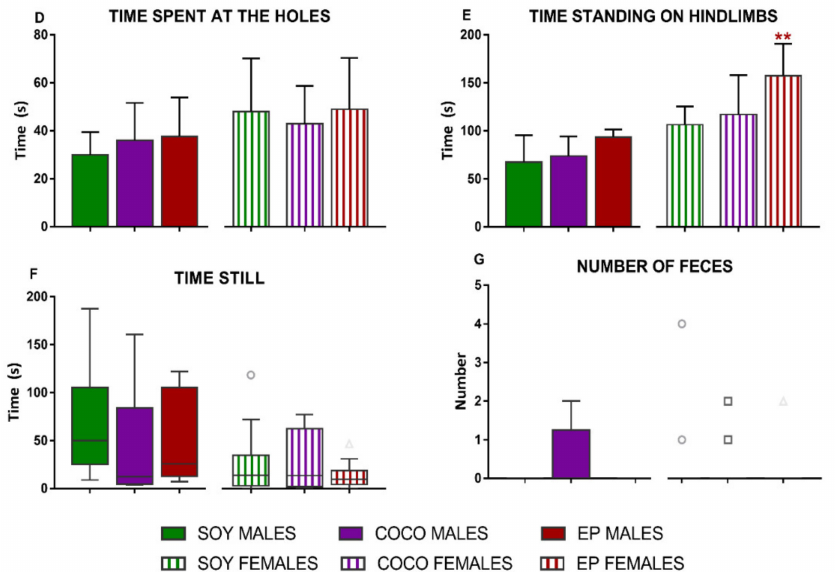
Figure 3. Effects of diet intervention on exploratory behavior (hole-board test) in the rat. Male and female rats were exposed to AIN-93G diet containing 7% of soybean oil (SOY), or to modified AIN-93G diet containing 3.5% of soybean oil supplemented with 3.5% of coconut oil (COCO) or with 3.5% of evening primrose oil (EP). Different parameters were evaluated during the test: total number of crossed squares ( A ), % of external ( B ) and internal ( C ) crossed squares, time spent at the holes ( D ), time standing on hindlimbs ( E ), time still ( F ), and number of feces expelled ( G ), analyzed in males and females separately. Data are expressed as means ± S.D. in normally distributed data and median and IQR when not normally distributed ( n = 6–10 animals per group). One-way ANOVA followed by Bonferroni’s multiple comparison or Kruskal–Wallis test followed by Dunn ´ s multiple comparison test. * p < 0.05, ** p < 0.05 vs. SOY females.